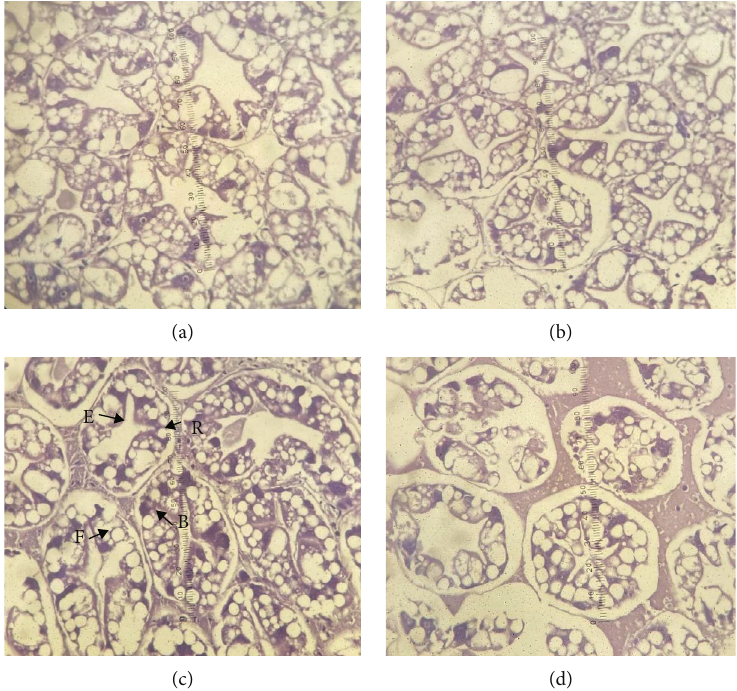
Figure 2: The hepatopancreatic in Paci fi c white shrimp fed with pineapple waste crude extract supplementation at di ff erent levels for 80 days: (a) 0ppt, (b) 90ppt, (c) 170 ppt, and (d) 250 ppt (H&E, × 10). E = embryonic; R = restorative; F = fi brillar; B =